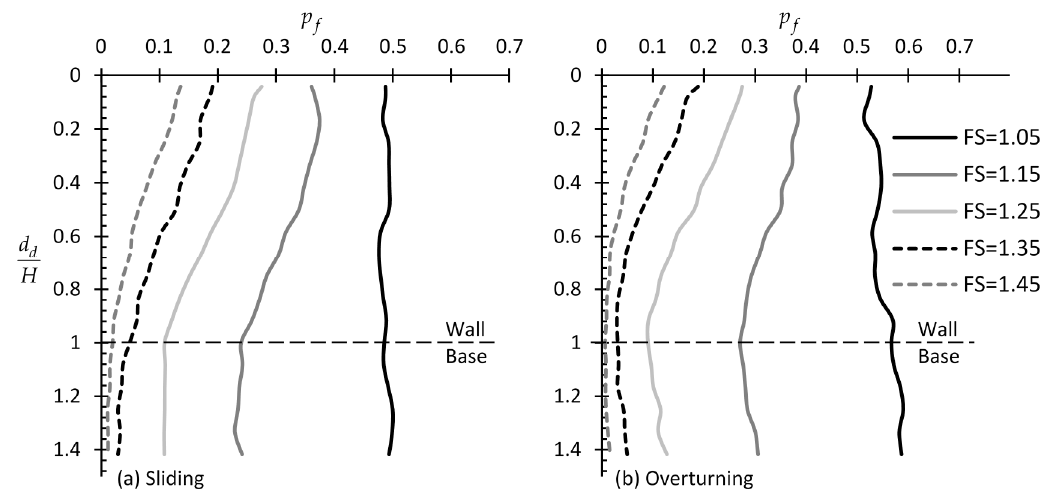
Figure 16. p f − d d / H curves for x / H = 0.5, θ / H = 2.08 and various FS values for the case of ( a ) sliding Figure 16. f p - d d H curves for x H = 0.5, H θ = 2.08 and various FS values for the case of and ( b ) overturning wall. ( a ) sliding and ( b ) overturning wall.